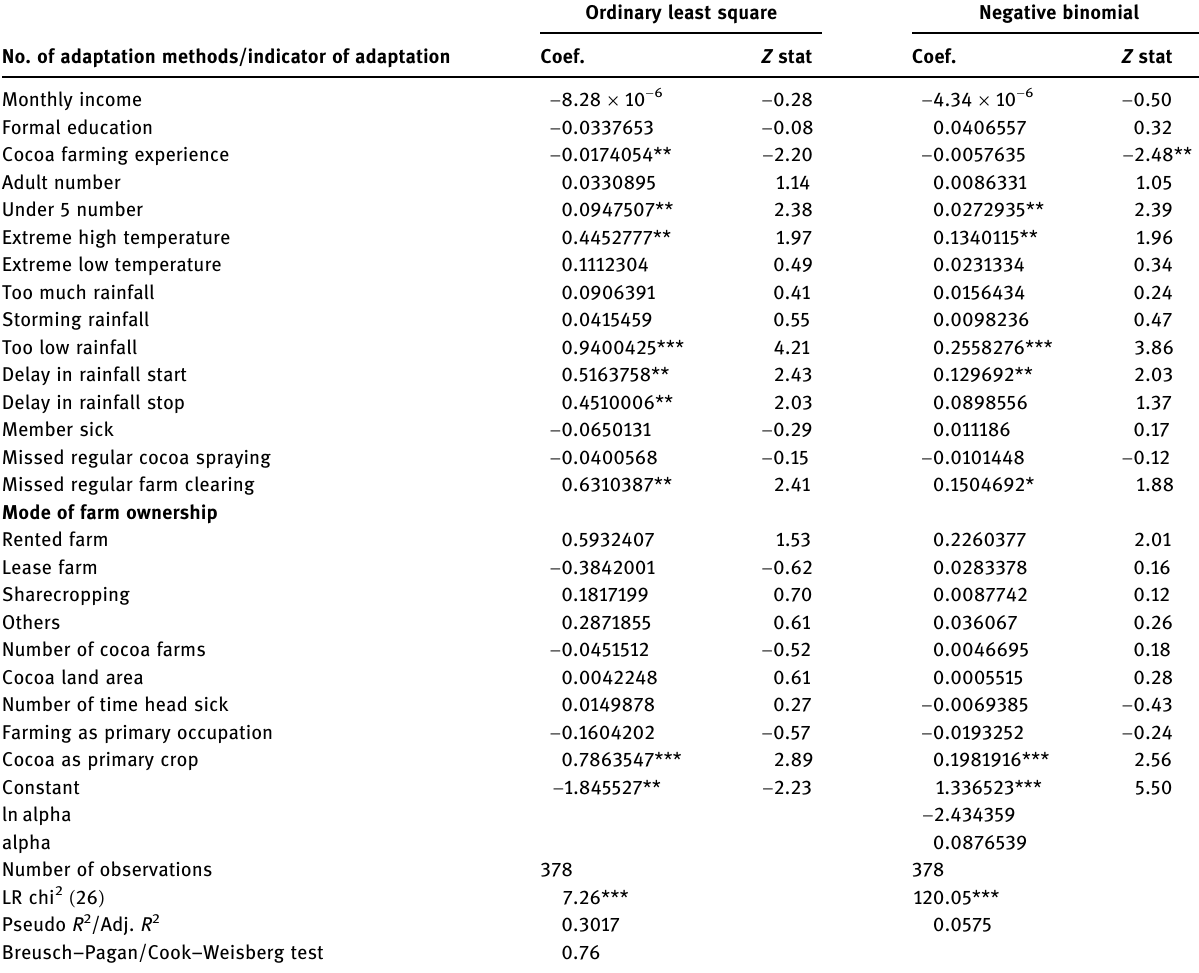
Table 5: Determinants of adaptation to climate